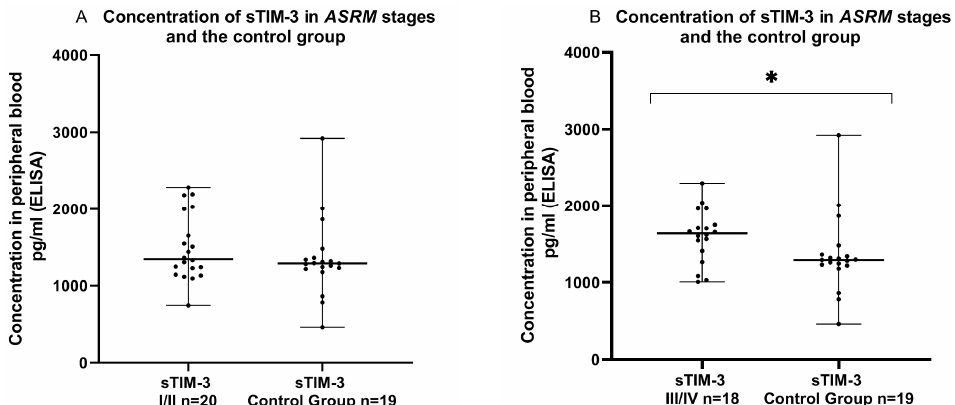
Figure 9. Level of sTIM-3 in the plasma in early (I/II) ( A ) and late (III/IV) ( B ) ASRM stages of endometriosis and in the plasma of the control group (pg/mL). The median value with the following sign indicate statistically significant difference: * p < 0.05.